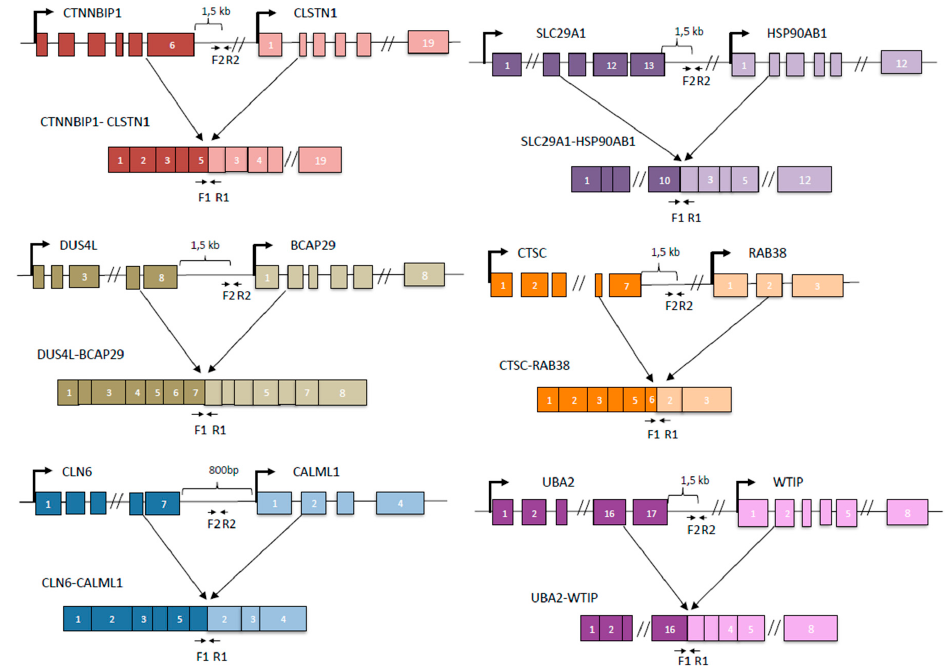
Figure 2. Cartoons depicting the configurations of cis-SAGe fusion RNAs and primer locations. For each fusion, upper level is the DNA configuration. Lower level is the chimeric RNA configuration. Primer set 1 (F1 and R1) is used to amplify the chimeric RNA. Primer set 2 (F2 and R2) is used to amplify DoG of the 5’ parental gene. Genes 2017 , 8 , 338